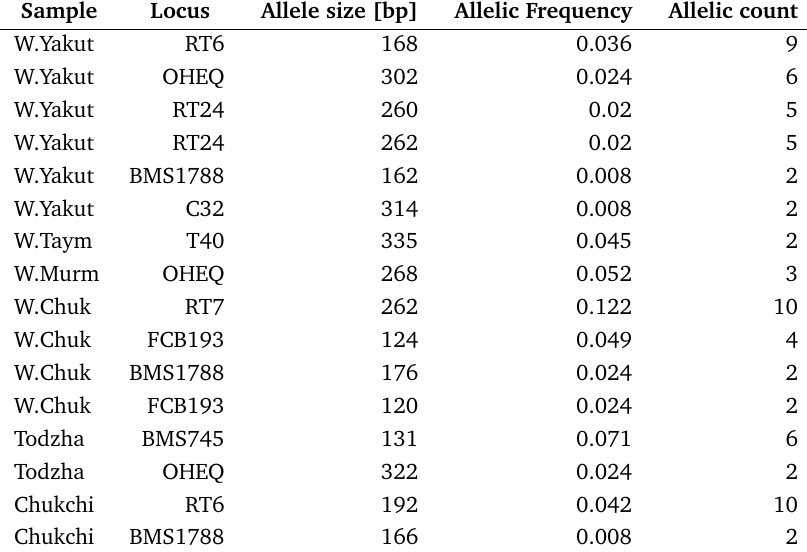
Table 3. Private alleles by locus and